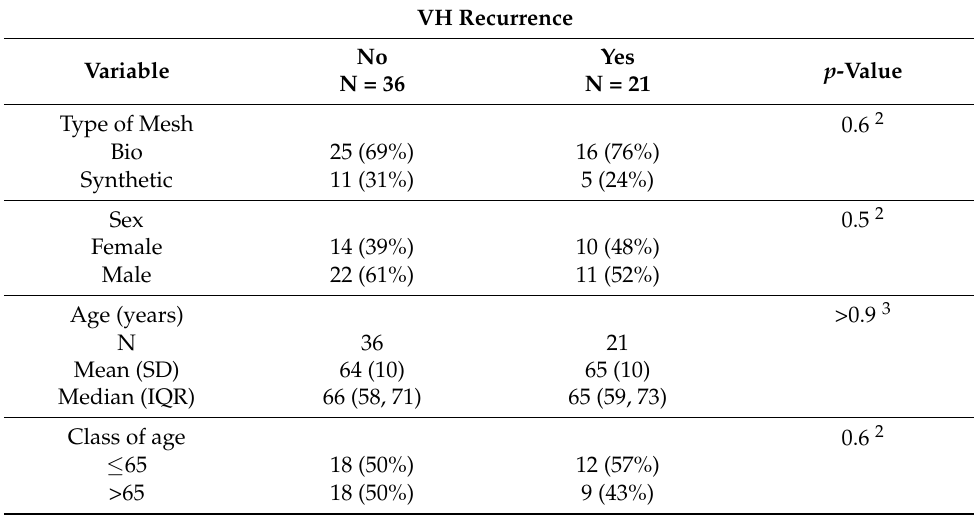
Table 2. Univariate analysis for VH